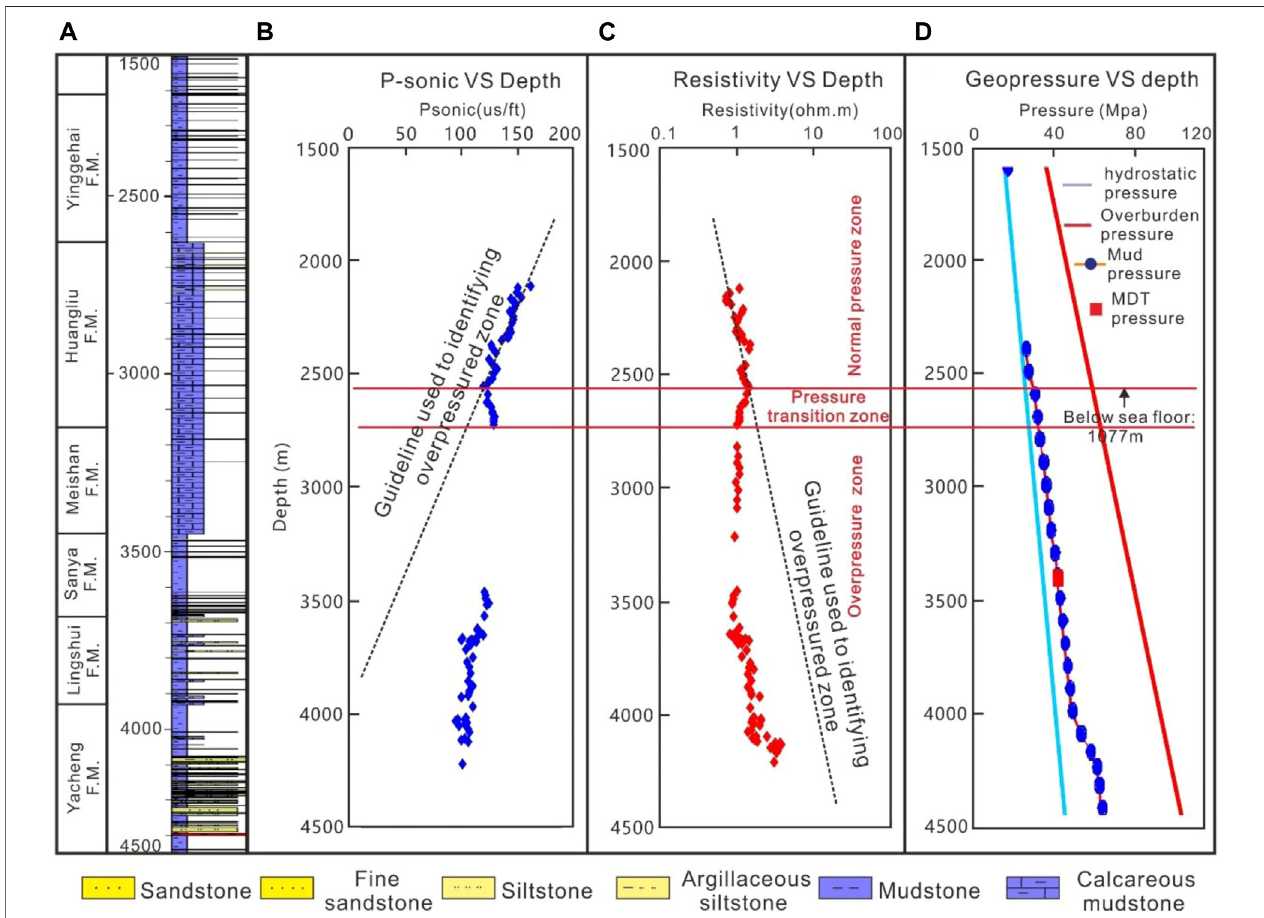
FIGURE 5 | (A) Lithologic pro fi le of Well B (B) Pseudo log of sonic P-wave transit times for mudstone. The plot shows the deviation of transit time from the compaction trend below about 2,550 m. The P-wave sonic data at the depth of 2,750 – 3,450 m were not measured. (C) Plot of log-derived resistivity values for mudstone showing deviation from the compaction trend below about 2,550 m. (D) Plot of calculated mud pressures and MDT pressures showing a corresponding positive deviation from hydrostatic pressure (overpressure) below about 2,550 m. A normal pressure zone, a pressure transition zone and an overpressure zone can be identi fi ed. The water depth in Well B is 1,473 m. The well location is shown in Figure 1 .